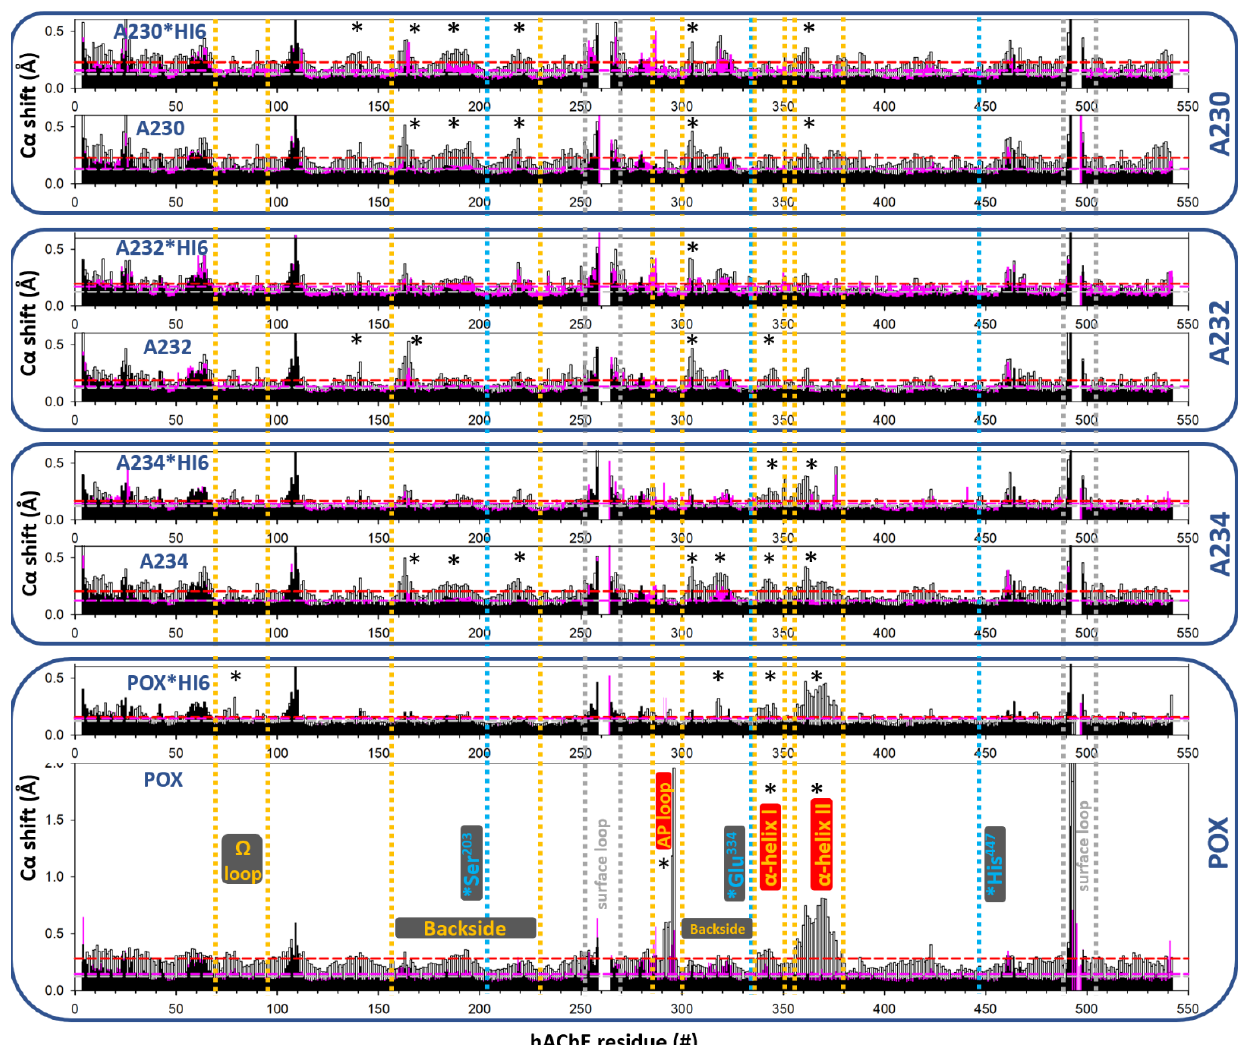
Figure 6. Alpha carbon shifts in the hAChE backbone upon covalent OP conjugation by A-type nerve agents A230, A232 and A234 and further reversible complex formation with HI6. The POX panel from Figure 4 is added for comparison. Graph description is the same as for Figure 4.